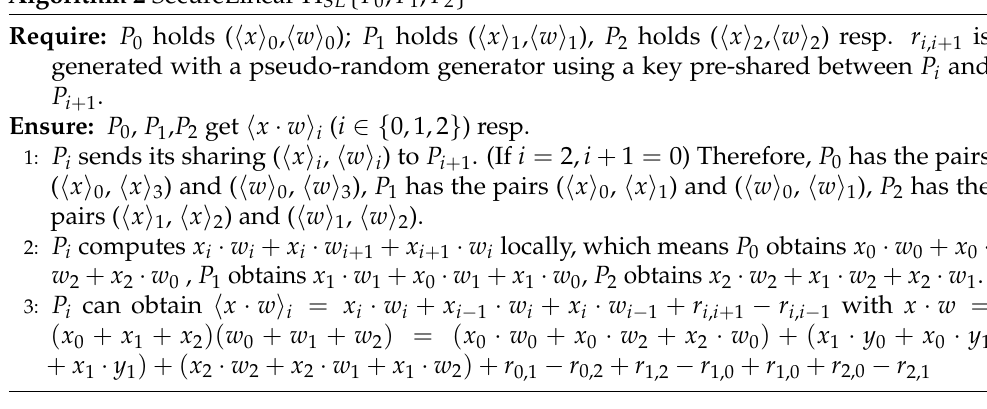
Algorithm 2 SecureLinear Π SL { P 0 , P 1 , P 2